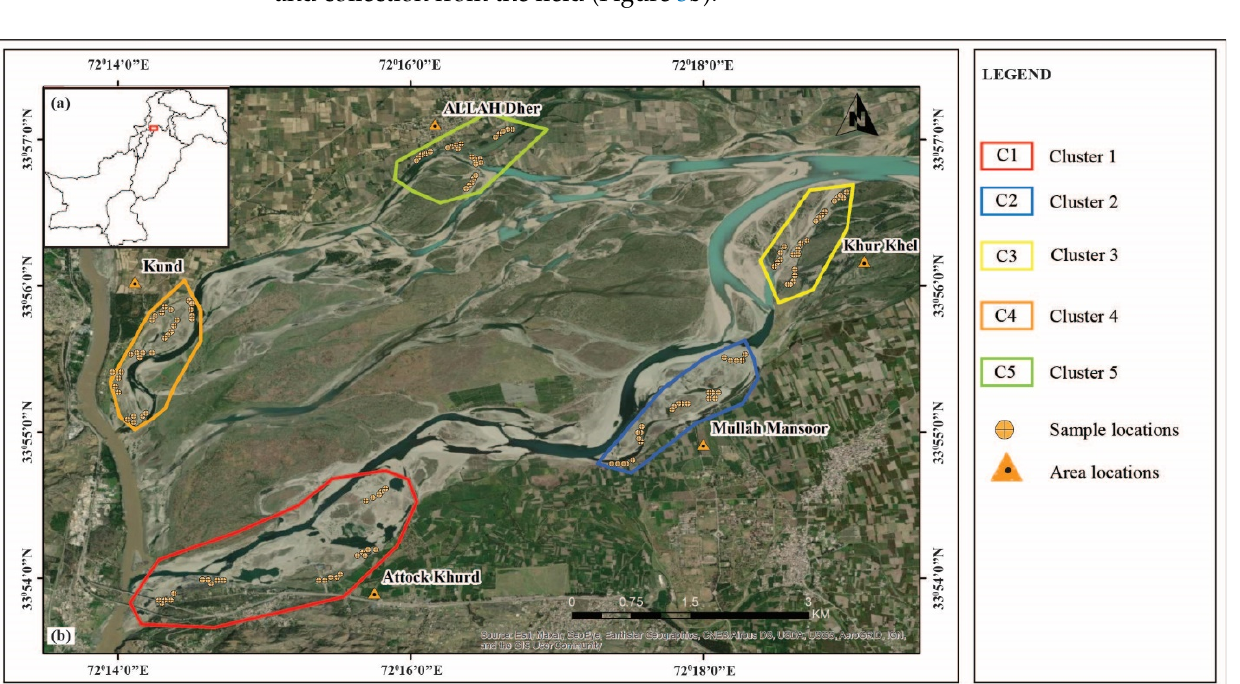
Figure 3. ( a ) Pakistan location map highlighting the red box of study area, ( b ) The different clusters were designed based on river morphology for sample collection along the Indus River.